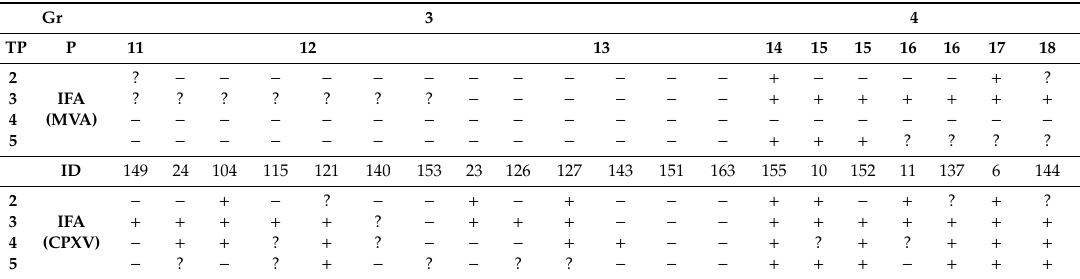
Table 3. Antibody titre changes using two di ff erent indirect immunofluorescence assays in the animals of group 3 (no seroconversion) and 4 (inconclusive titre